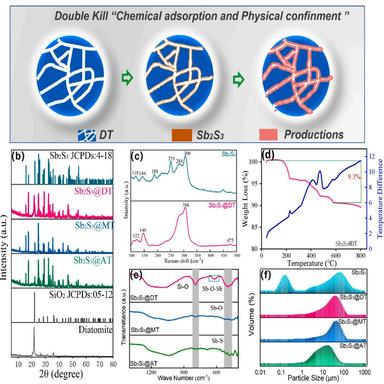
Fabrication mechanism diagram of Sb2S3@DT(a). Physicochemical properties of the as-prepared three samples: (b) XRD patterns and corresponded PDF card, (c) Raman curves, (d) TG curves of Sb2S3@DT, (e)FTIR curves, (f)size distribution.